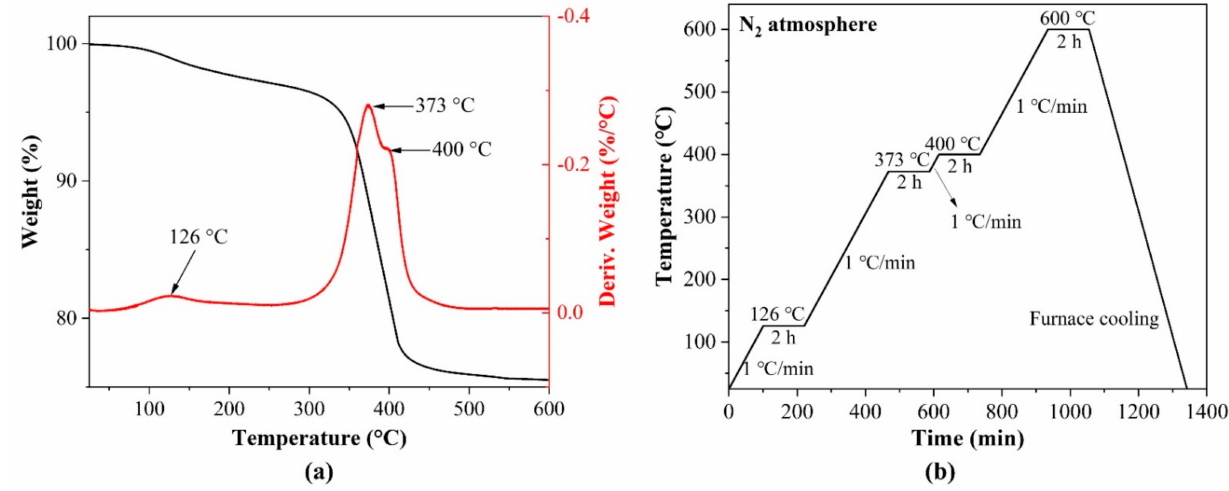
Figure 1. ( a ) TGA result of mica green body and ( b ) debinding profile.